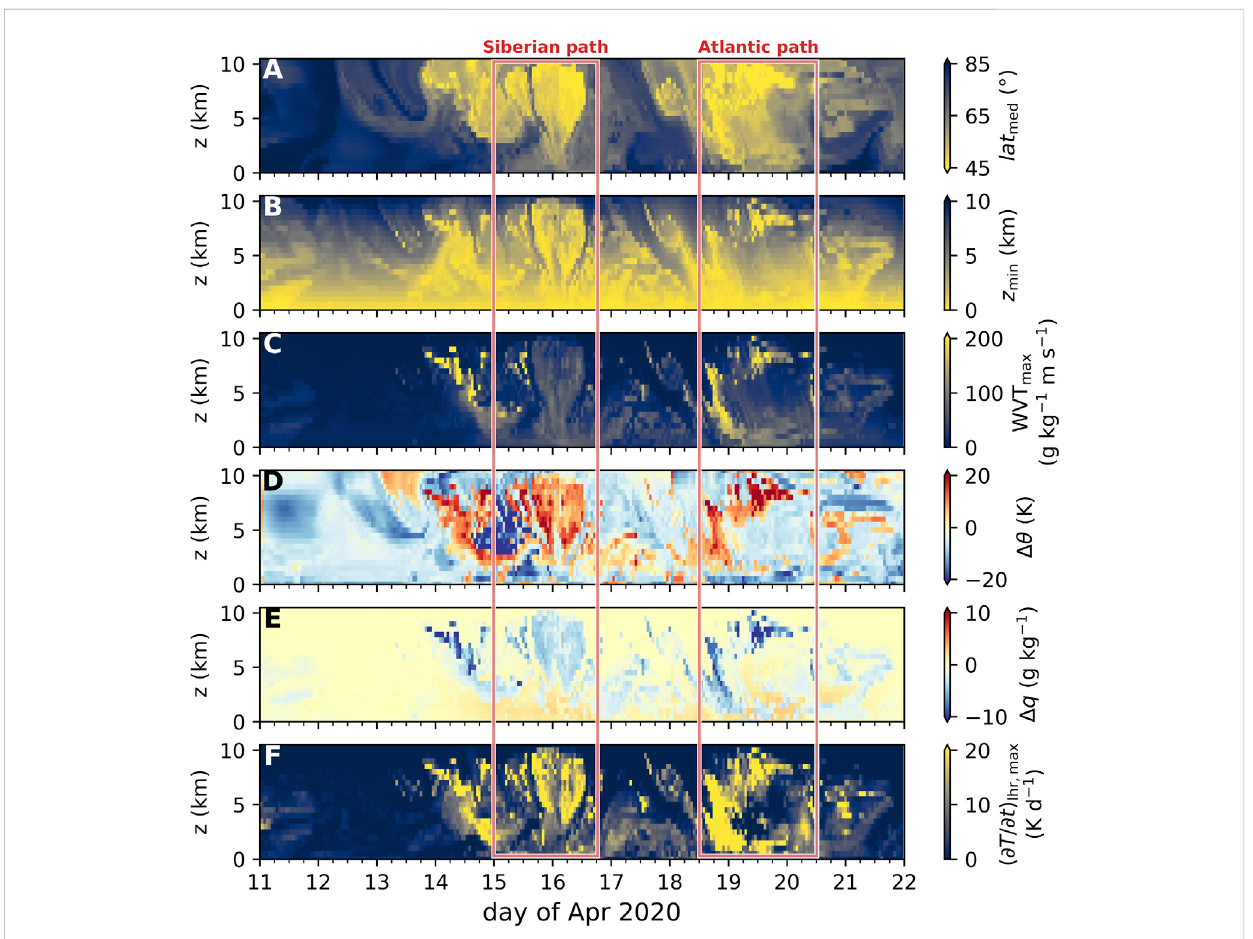
Characteristics of 5-day backward trajectories based on ERA5 starting at RV Polarstern for altitudes from the surface up to 10 km, mid-April 2020. Shown are (A) median latitude that the air masses occupied in the previous 5 days, (B) the lowest altitude at which air masses had resided, (C) maximum water vapor transport, (D) maximum change of potential temperature θ with respect to the fi nal state, (E) maximum change of speci fi c humidity q with respect to the state, and (F) maximum temperature tendency due to latent heat release during cloud